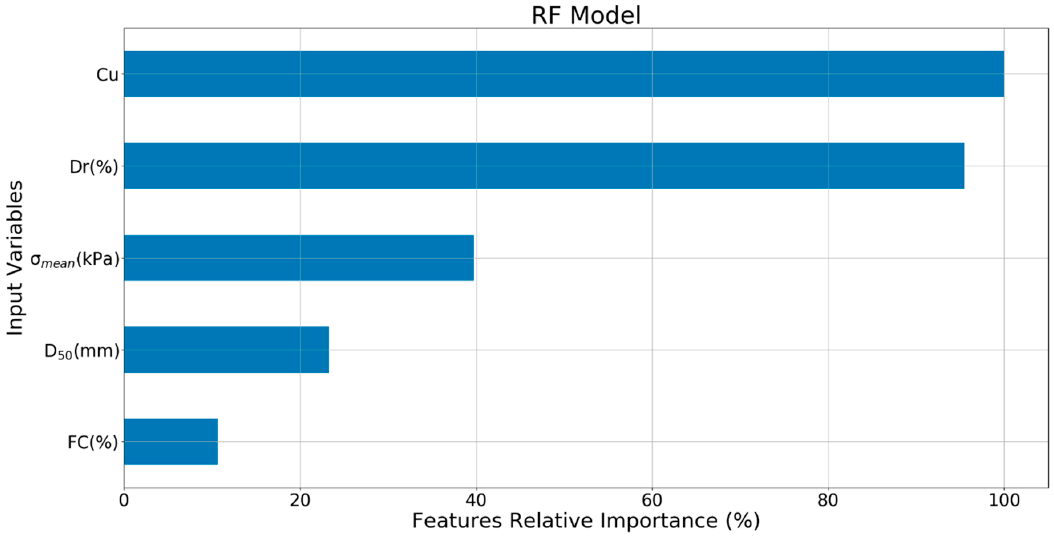
Figure 22. Importance of the input variables for the developed RF model.